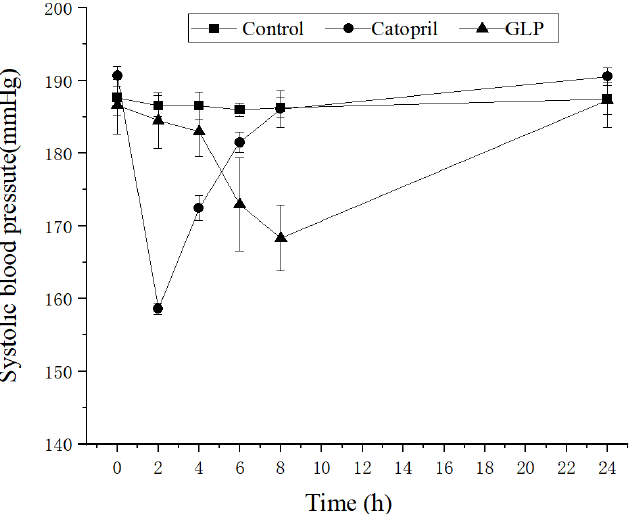
Figure 2. Systolic blood pressure changes in spontaneously hypertensive rats after the oral administration of G. lemaneiformis peptide.